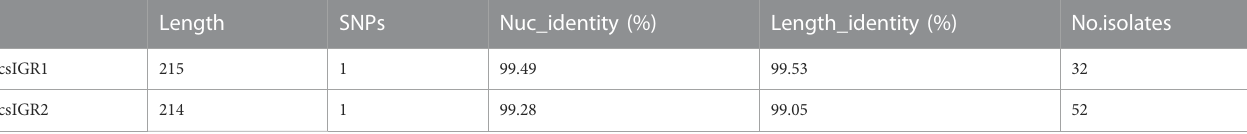
TABLE 3 The two versions of the csIGR in-between the single copy core genes. csIGR1 is present in 32 of the isolates analyzed and is highly conserved across the genomes with an average nucleotide identity of 99.49%. csIGR2 is present in 52 of the strains analyzed and is likewise highly conserved with an average nucleotide identity of 99.28%. Both IGRs have roughly the same length in base